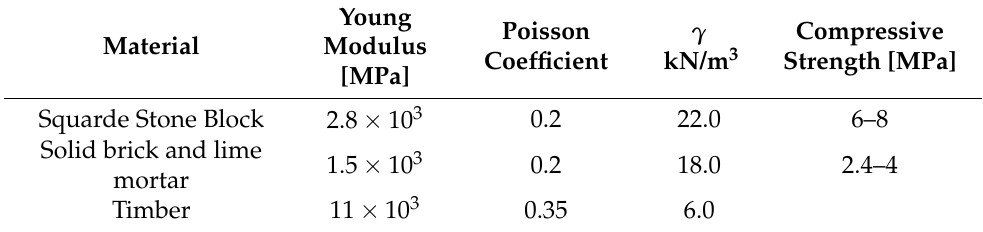
Table 1. Mechanical characteristics of masonry and timber.